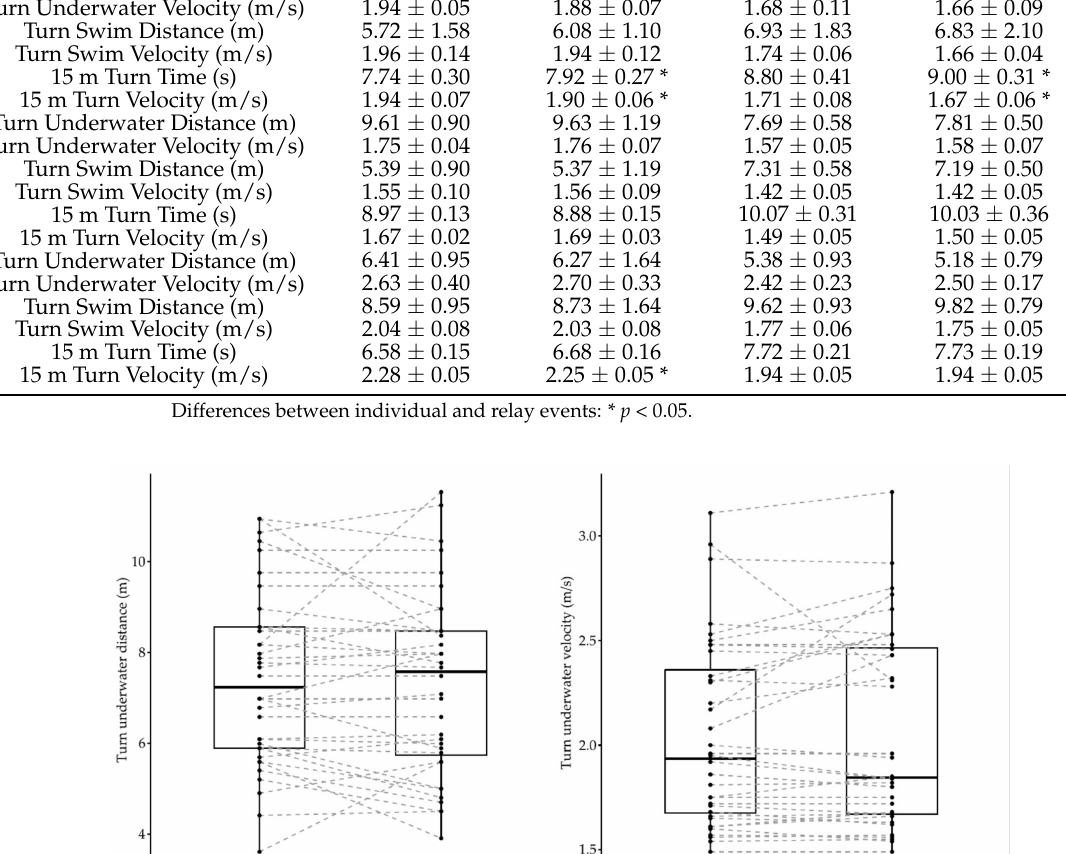
Individual Relay Individual Relay Butterfly Turn Underwater Distance (m)